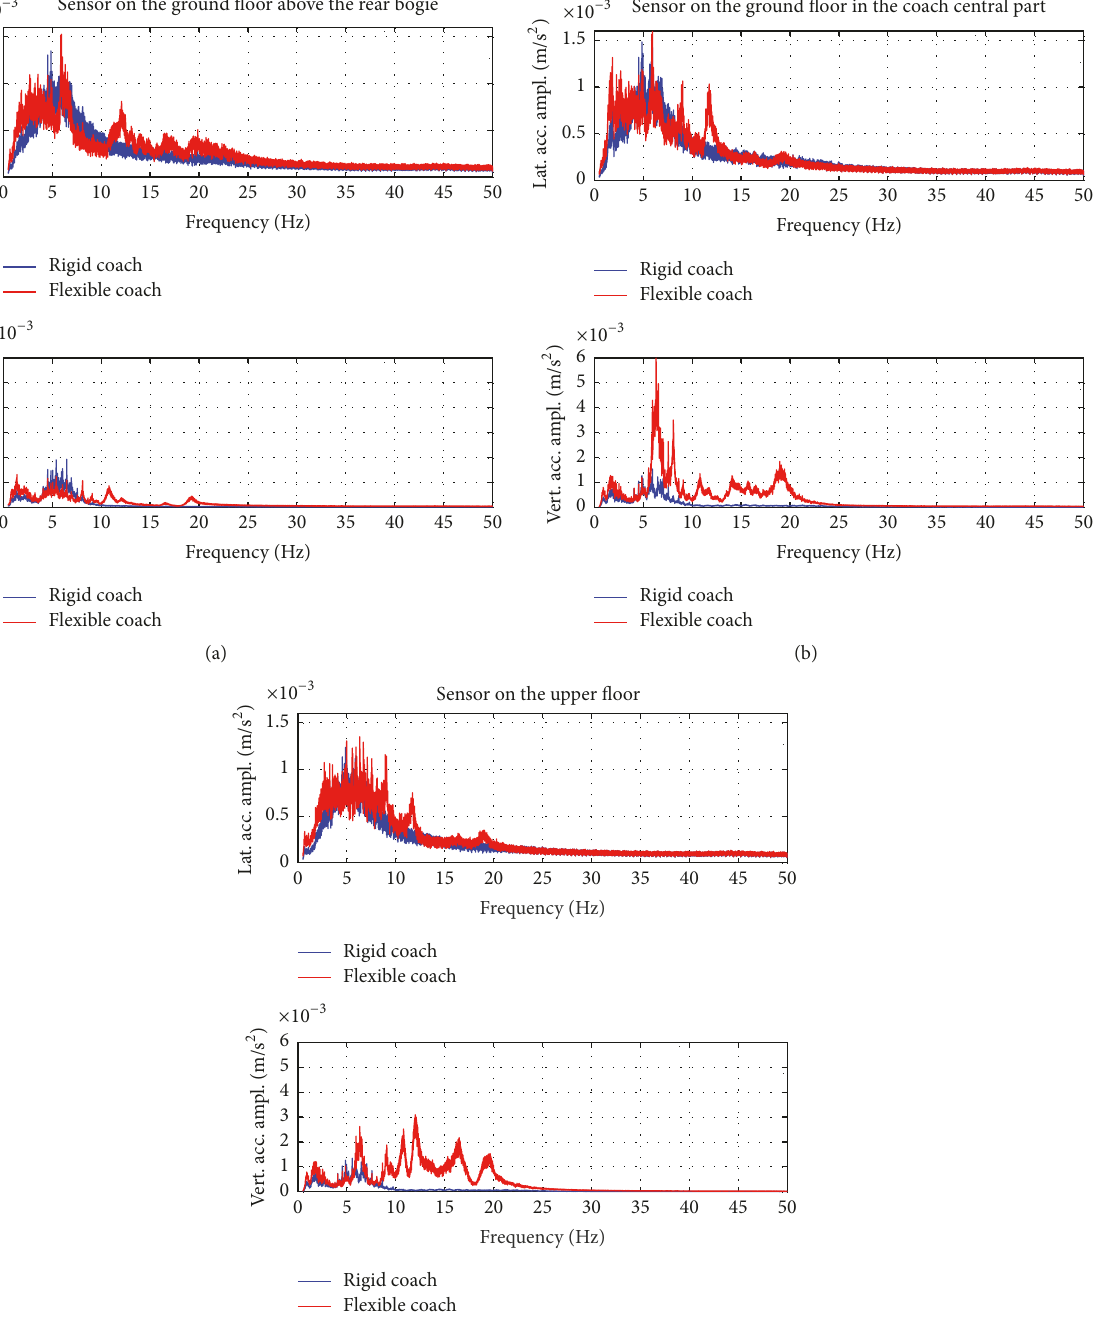
the lateral acceleration is mainly affected by the bogie modes that are in the frequency range 0–7 Hz. The longitudinal acceleration is not shown since this direction is not affected by the coach